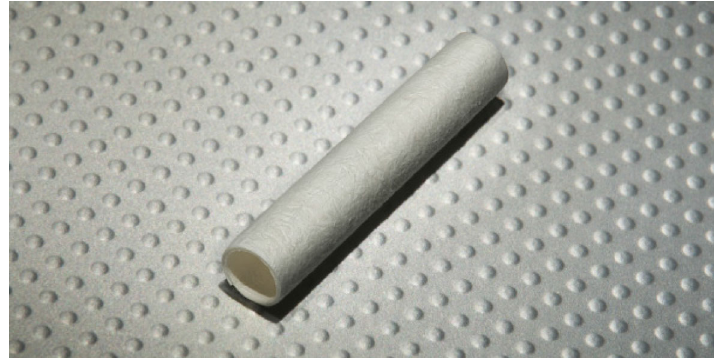
Figure 1: TenoMend ™ comes as a machined pre-curled resorbable type I collagen. (Re-Printed with Permission from Exactech, Gainesville, FL).